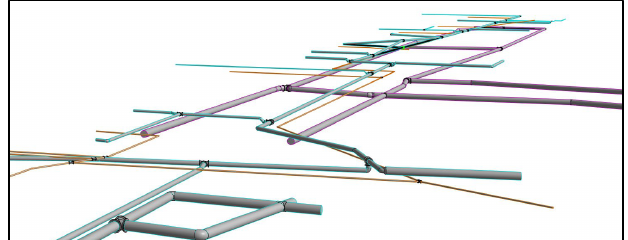
Figure 11. MEP model on Revit.